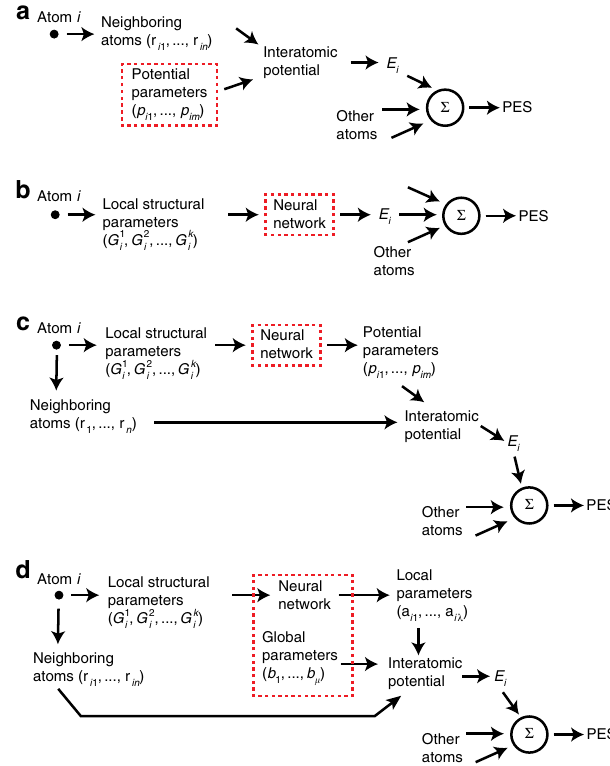
Fig. 1 Flowcharts of the development of atomistic potentials. a Traditional interatomic potential. b Mathematical NN potential. c Physically informed NN (PINN) potential with all-local parameters. d PINN potential with parameters divided into local and global. The dashed rectangle outlines the objects requiring parameter optimization. PES is the potential energy surface of the